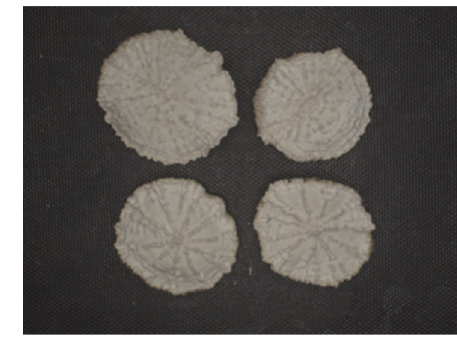
Table 3. Color values, rehydration ratios, energy consumptions, drying times, total sugar contents, and comprehensive scores under different drying conditions.